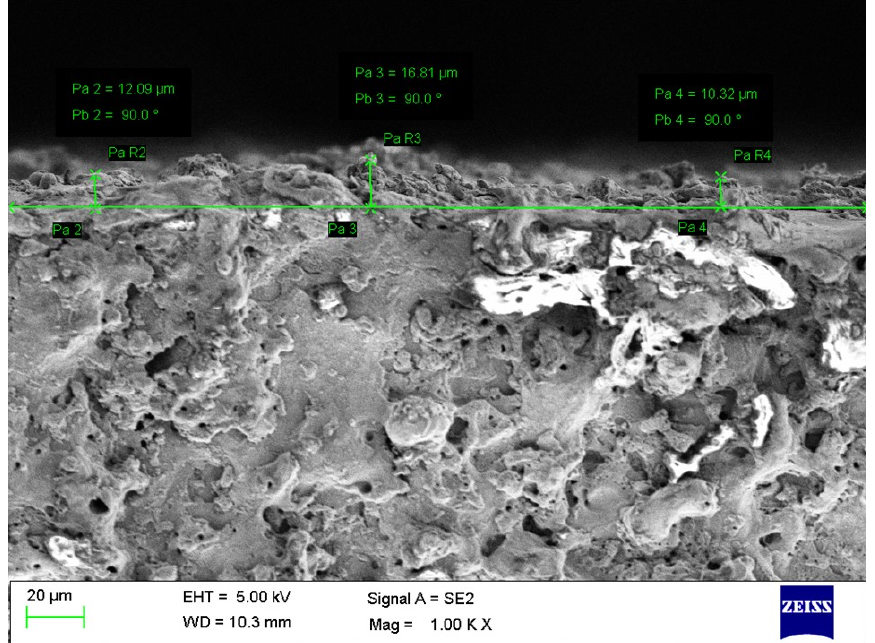
Figure 2. SEM image for measurement of RLT of experimental trial 1.